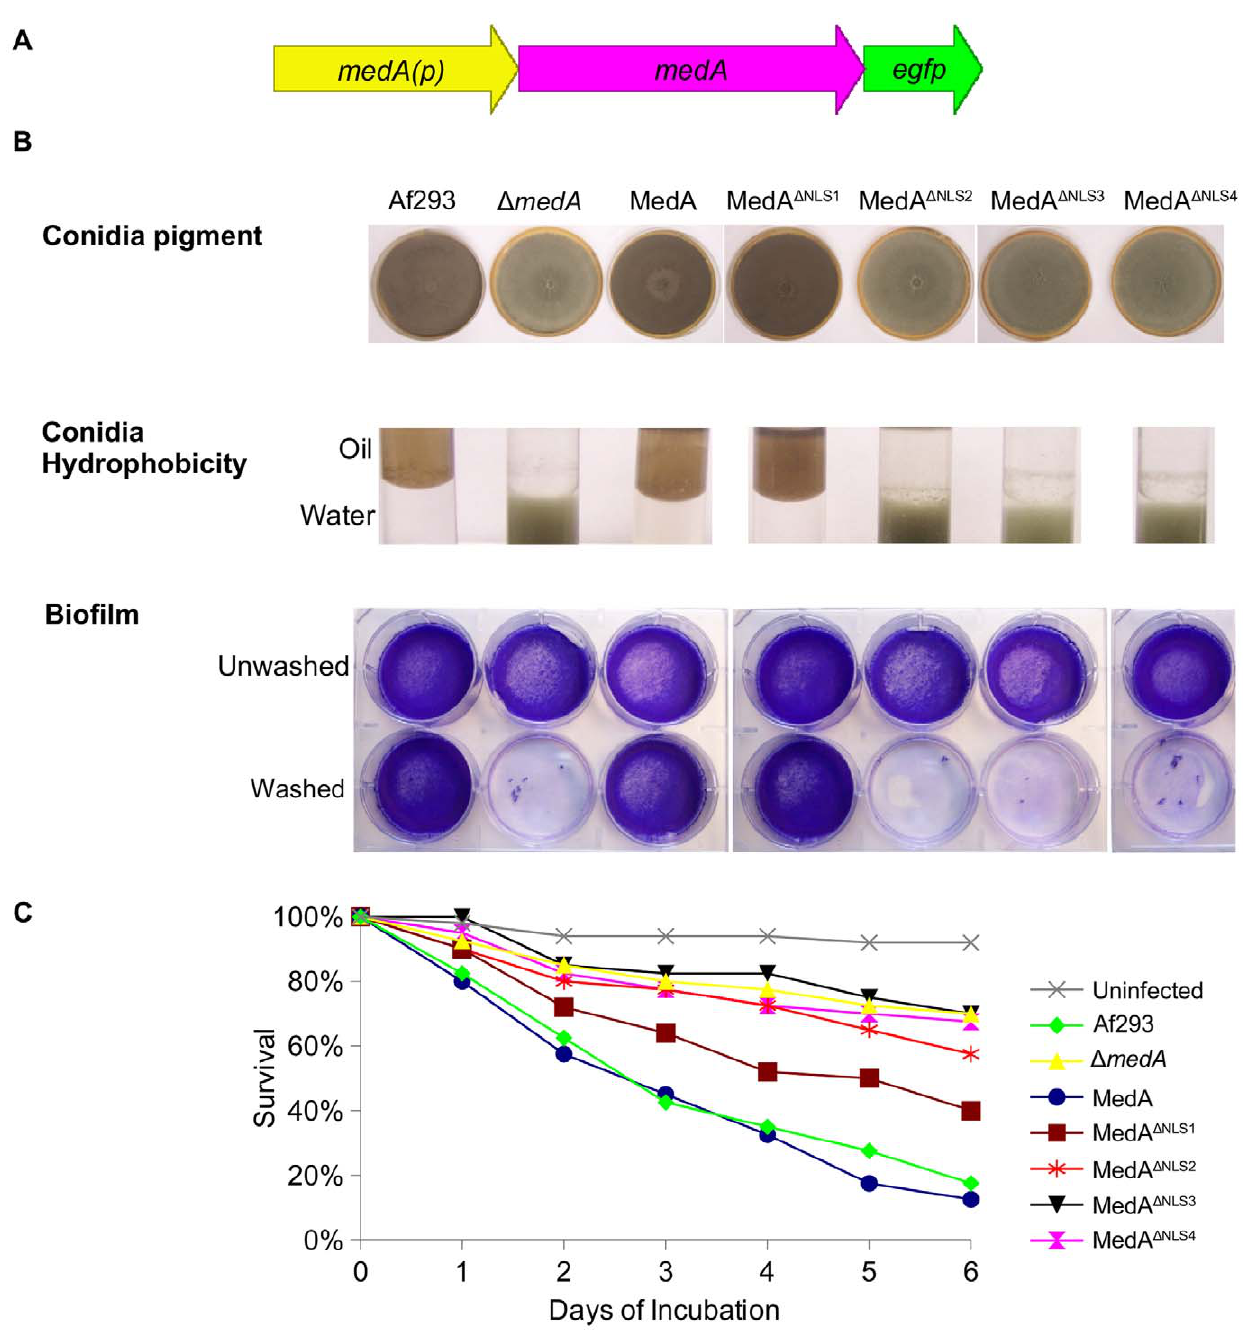
Figure 5. Effect of MedA nuclear localization on restoring wild type phenotype. (A) Schematic overview of the medA-egfp fusion constructs under the control of the 1.5 kb medA promoter, medA(p) used for complementation of the D medA strain. (B) Vegetative growth of strains on Sabouraud agar for 6 days at 37 u C; hydrophobicity of conidia; and biofilm formation before and after washing. (C) Survival assay of G. mellonella larvae. 40 worms/strain were infected with 10 5 swollen conidia. Af293 indicates the A. fumigatus wild type strain; MedA, MedA D NLS1 , MedA D NLS2 , MedA D NLS3 , and MedA D NLS4 indicate expression of the corresponding construct under the control of the medA(p) in the D medA strain. Virulence of strains expressing cytoplasmic and nuclear MedA was compared to Af293 and D medA strain, respectively, using the log rank test. For all comparisons, P was # 0.05.